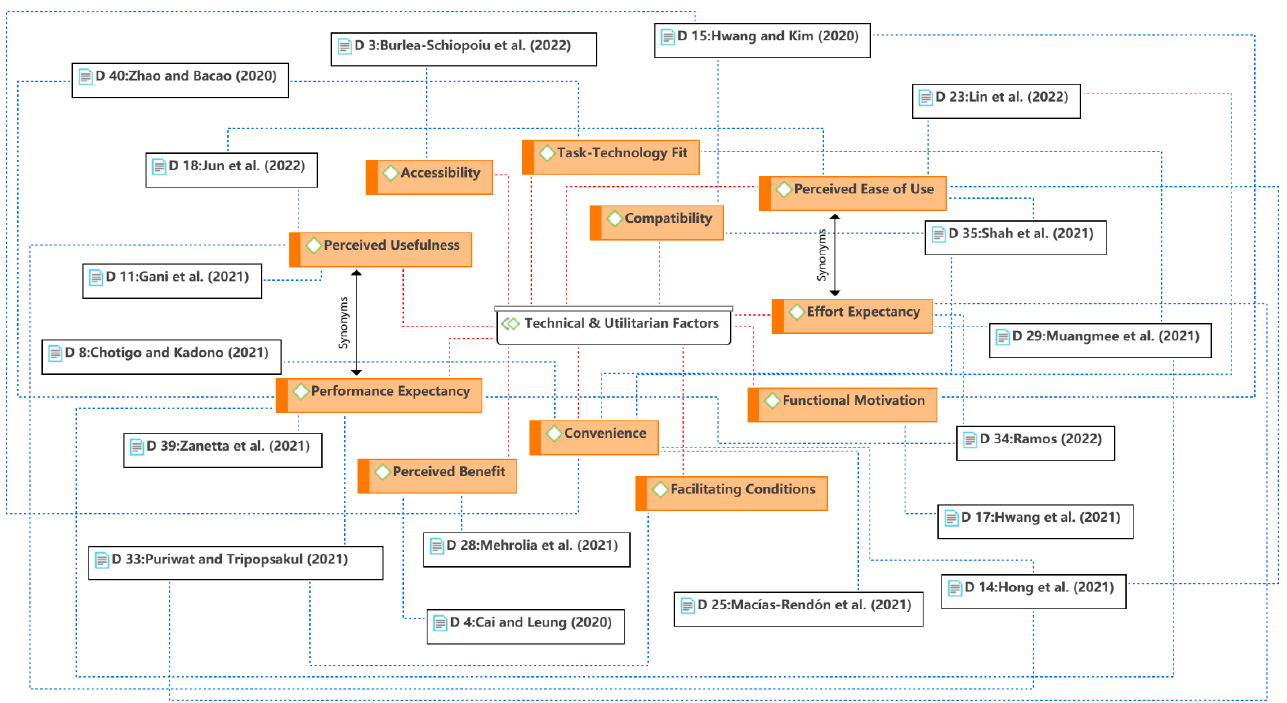
Figure 5. Theme 1: technical and utilitarian factors [6,12,13,15,26,35 – 37,42,44,46,48,53 – 56,58].